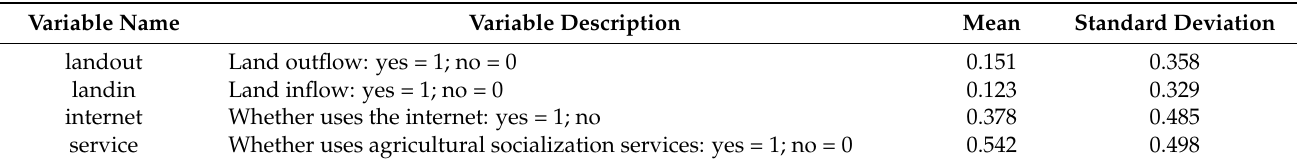
Table 1. Descriptive